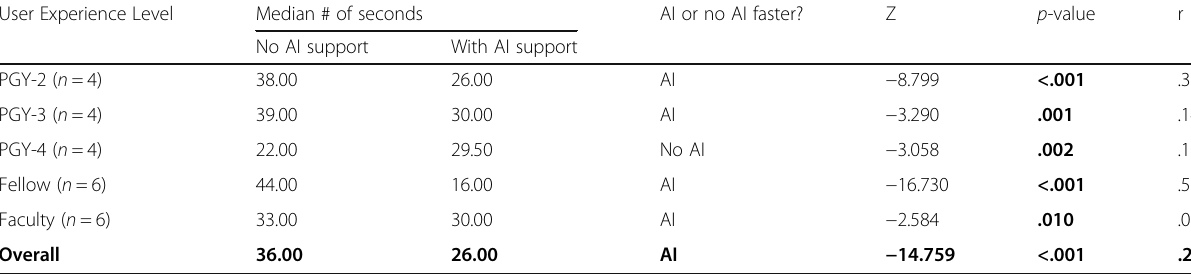
Table 4 Median time to count mitoses by study participant experience level User Experience